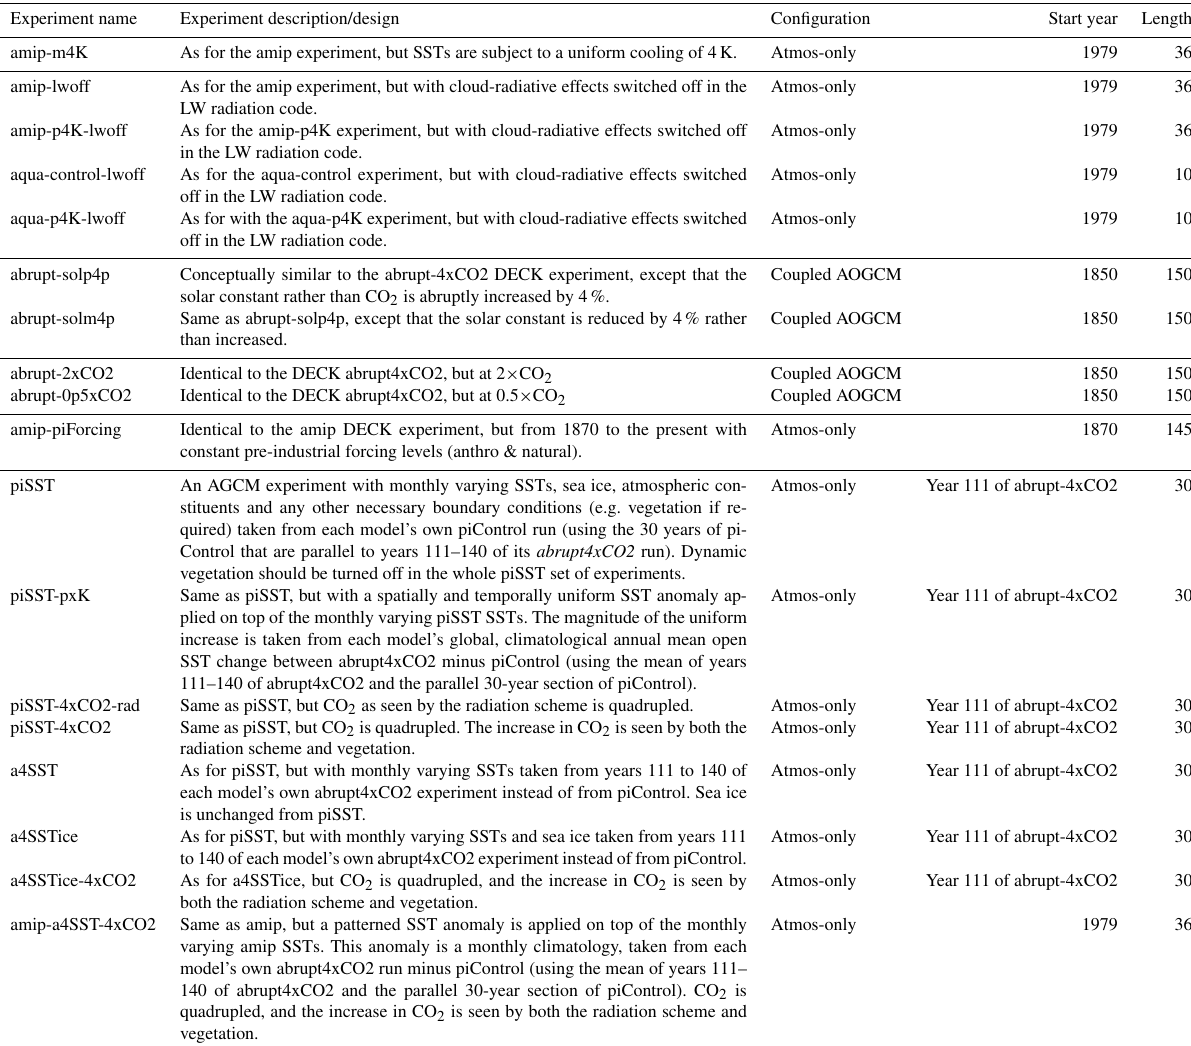
Table 2. Summary of CFMIP-3/CMIP6 Tier 2